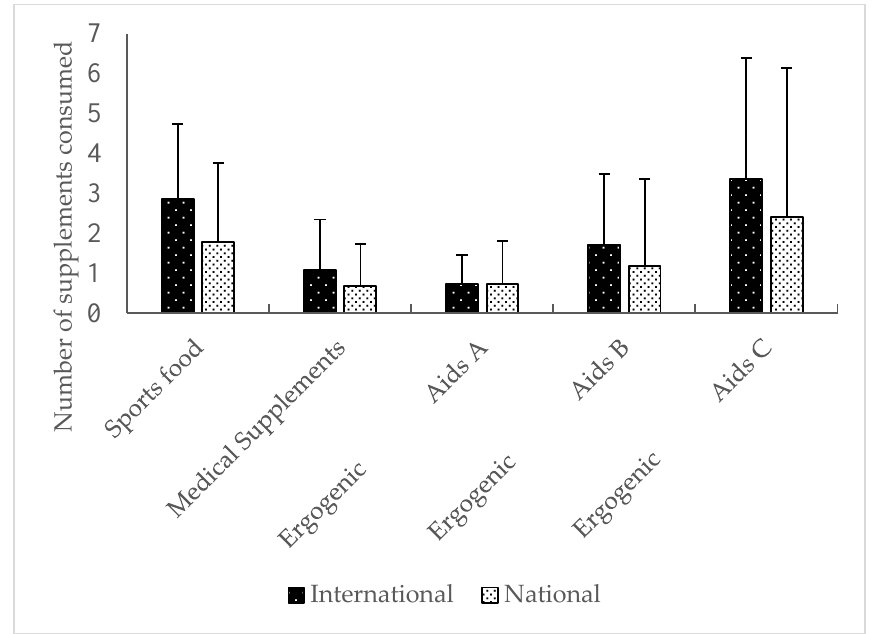
Figure 1. Number of supplements consumed by the international-level and national-level athletes’ group.